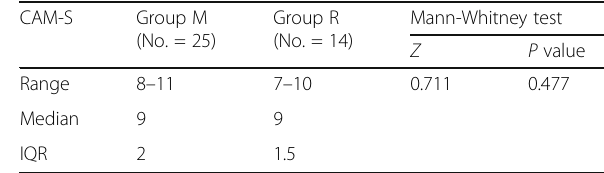
Table 4 Confusion Assessment Method (CAM) score Table 5 CAM-S score in both